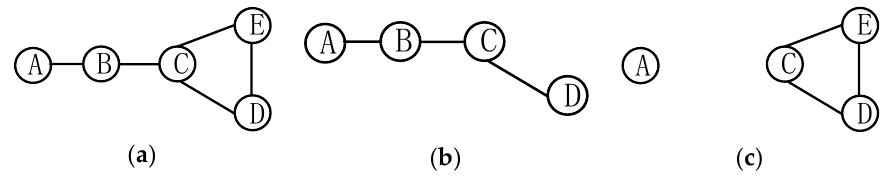
Figure 3. Example of network. ( a ) The original network; ( b ) The network of node E removed; ( c ) The network of node B removed.